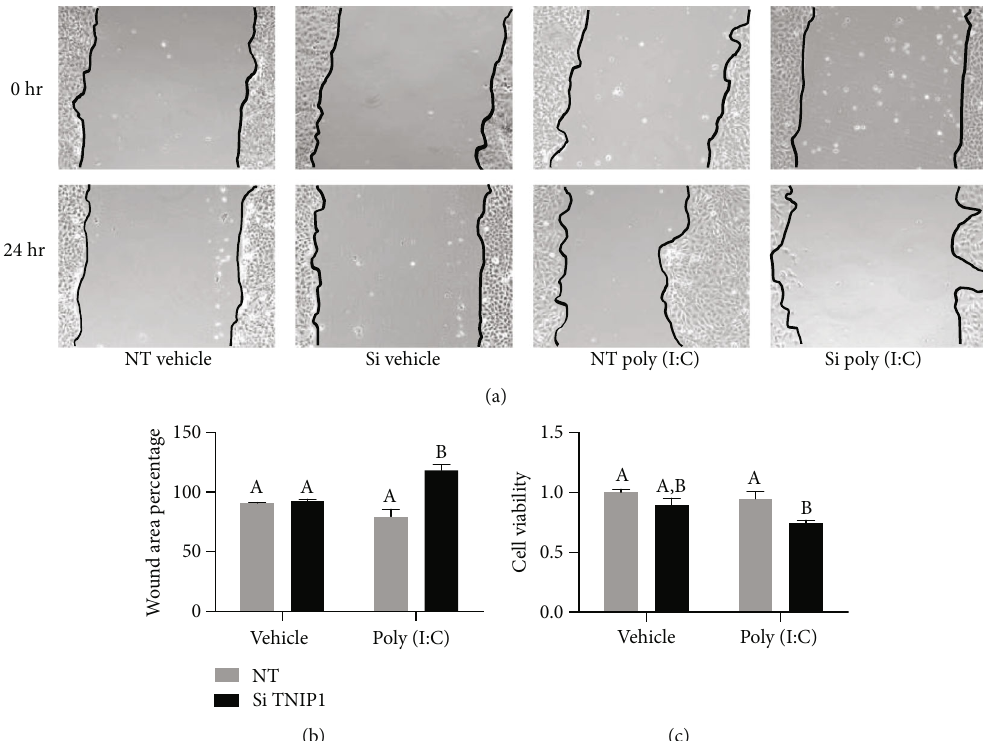
Figure 3: TNIP1 de fi ciency signi fi cantly inhibits HaCaT keratinocyte reepithelialization postscratch in the presence of low levels of TLR3 agonist poly (I:C). (a) A scratch “ wound ” in HaCaT keratinocyte monolayers was generated two days after nontargeting (NT) or TNIP1 (Si) siRNA transfection and then exposed to either vehicle or poly (I:C) (1 μ g/mL). Representative images ( n = 45 , 15 from each triplicate well) were taken at this time (0 hr) and again one day (24 hr) later. (b) Wound area percentage remaining (0 hr considered 100%) 24hr postscratch was calculated using TScratch software. (c) Cell viability was determined by MTS assay 72 hr posttransfection of HaCaT cells with either nontargeting or TNIP1 siRNA, exposed to poly (I:C) (1 μ g/mL) (or vehicle control) for the last 24hr. Data is presented as mean + SEM from two independent experiments with conditions in each set in triplicate. Statistical analysis was performed using two-way ANOVA followed by Bonferroni ’ s post hoc test. Asterisk ( ∗ ) represents statistically signi fi cant di ff erence ( ∗ p value of ≤ 0.05; ∗∗ p value of ≤ 0.005; NS: nonsigni fi